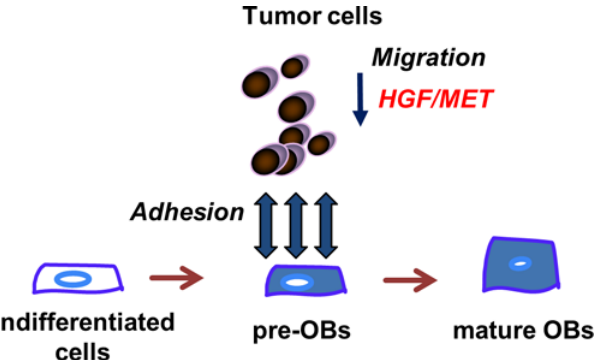
Fig 6. Schematic representation of the interactions between pre-OBs and tumor cells. Pre-OBs enhance migration of breast cancer (BC) cells via activation of the HGF/MET pathway. In addition, metastatic BC cells preferentially adhere to